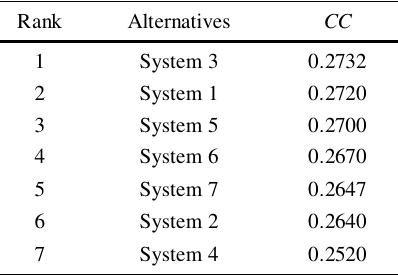
Table 5 The distances of alternatives to positive / negative Table 6 Ranking of